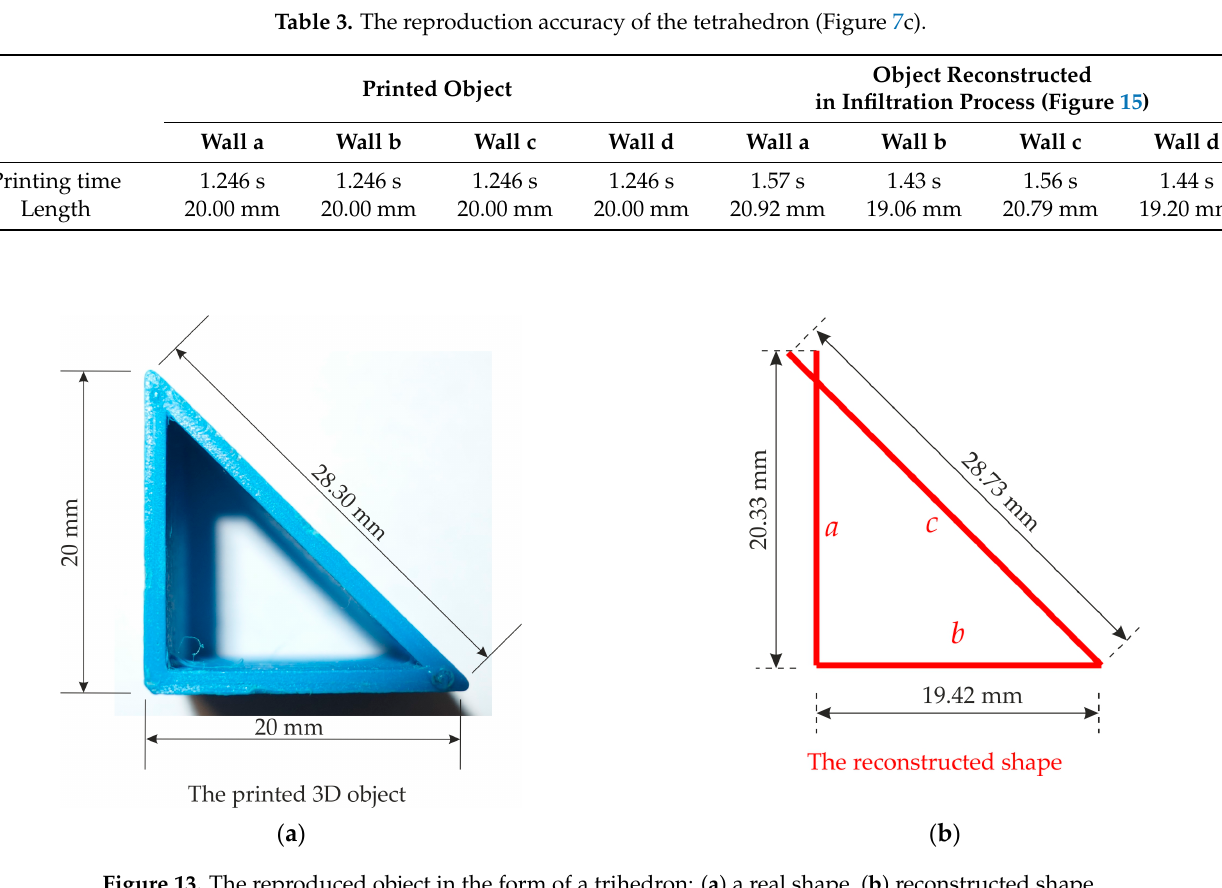
Figure 13. The reproduced object in the form of a trihedron: ( a ) a real shape, ( b ) reconstructed shape. Table 1. The reproduction accuracy of the trihedron (Figure 7a).